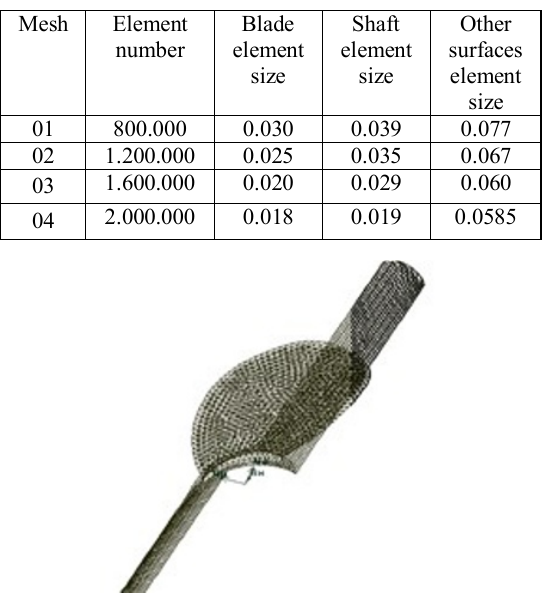
Figure 3 .Blade and shaft tetrahedral mesh